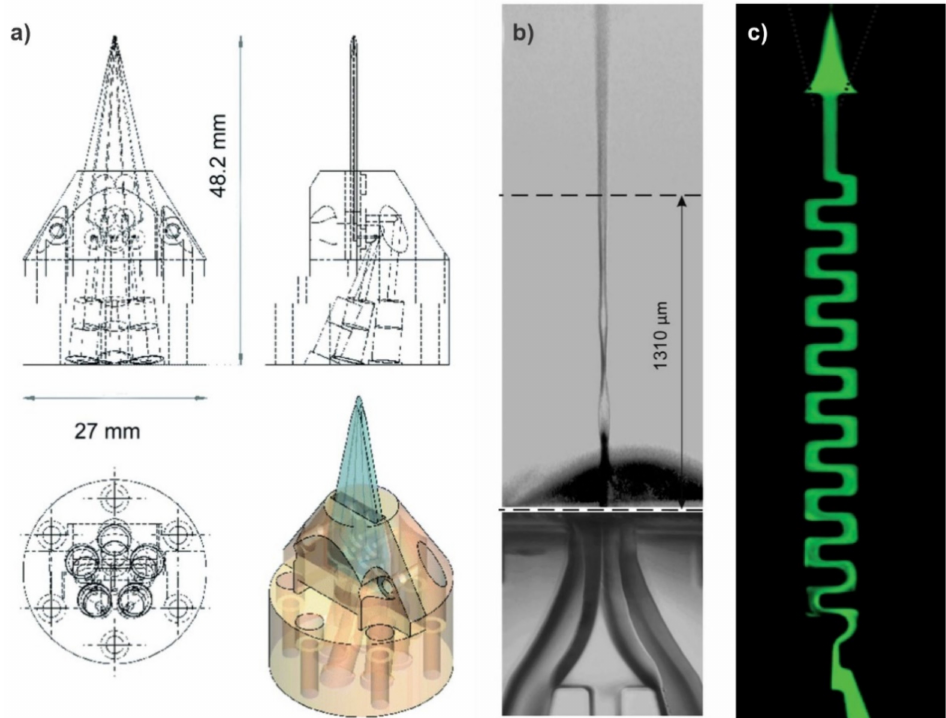
Figure 6. The SU8 on glass microfluidic mix-and-jet devices, ( a ) 3D schematics showing how the microfluidic chip is interfaced to tubing using a custom-made jig, ( b ) the ribbon regime created by the microfluidic mix-and-jet devices under gas flow rates ranging from 162 to 234 mg/min and liquid flow rates of 80 to 100 µ L/min, ( c ) mixing of water and a diluted fluoresceine salt solution in the serpentine mixing component (reproduced with permission from Reference